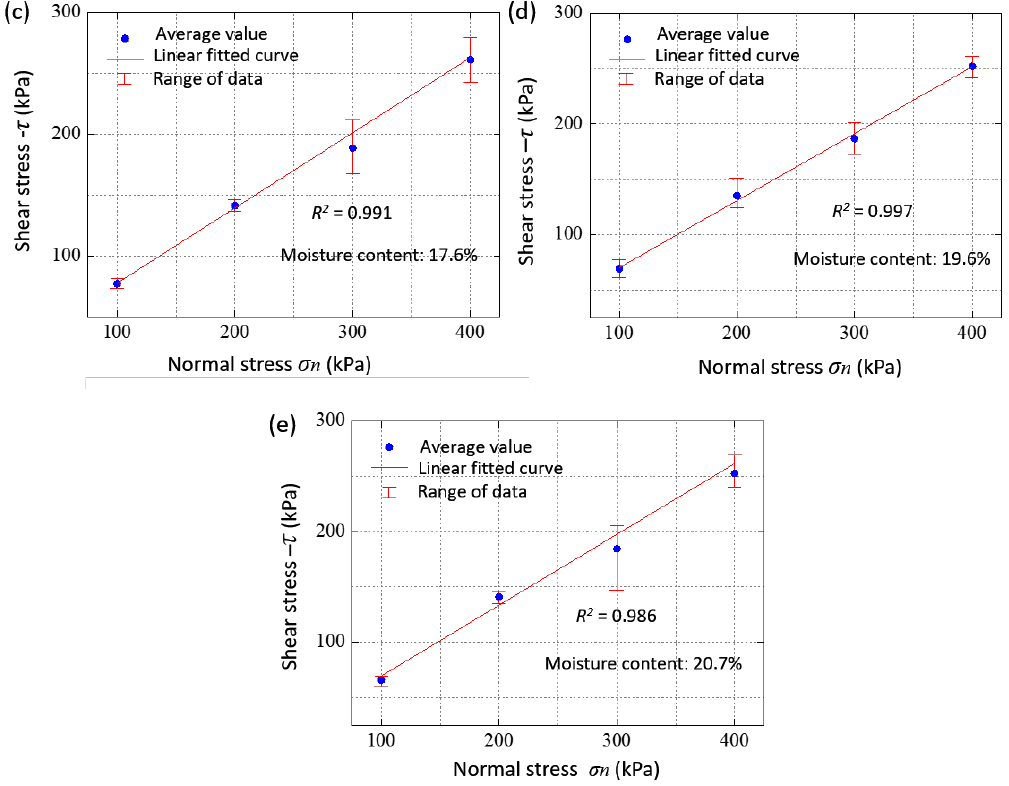
Figure 5. Linear regressive curves of the experimental data. ( a ) Moisture content is 6.6%; ( b ) Moisture content is 12.3%; ( c ) Moisture content is 17.6%; ( d ) Moisture content is 19.6%; ( e ) Moisture content is 20.7%.